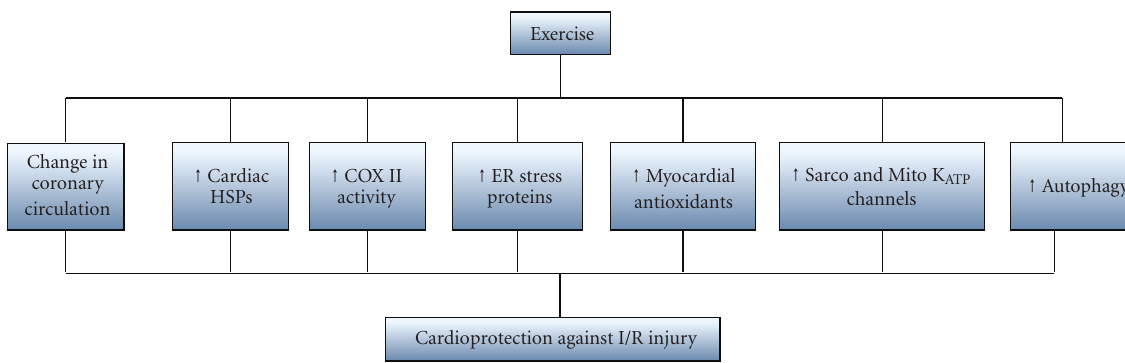
Figure 2: Proposed mechanisms for exercised-induced